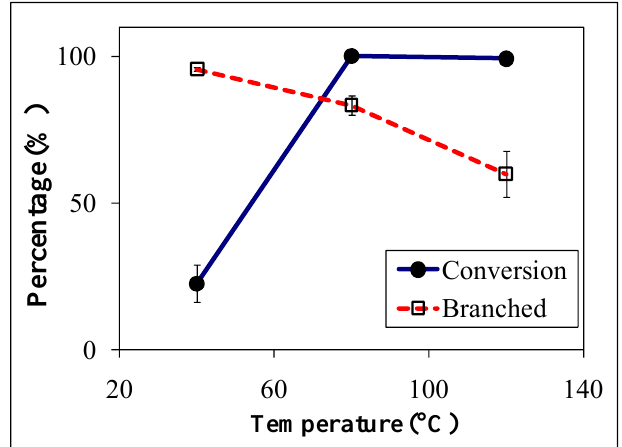
Figure 6. Conversion and branched product yield of p -methylstyrene hydroformylation in ACN/H O with 30 bar syngas pressure and catalyst:ligand:substrate ratio of 1:7:400 2